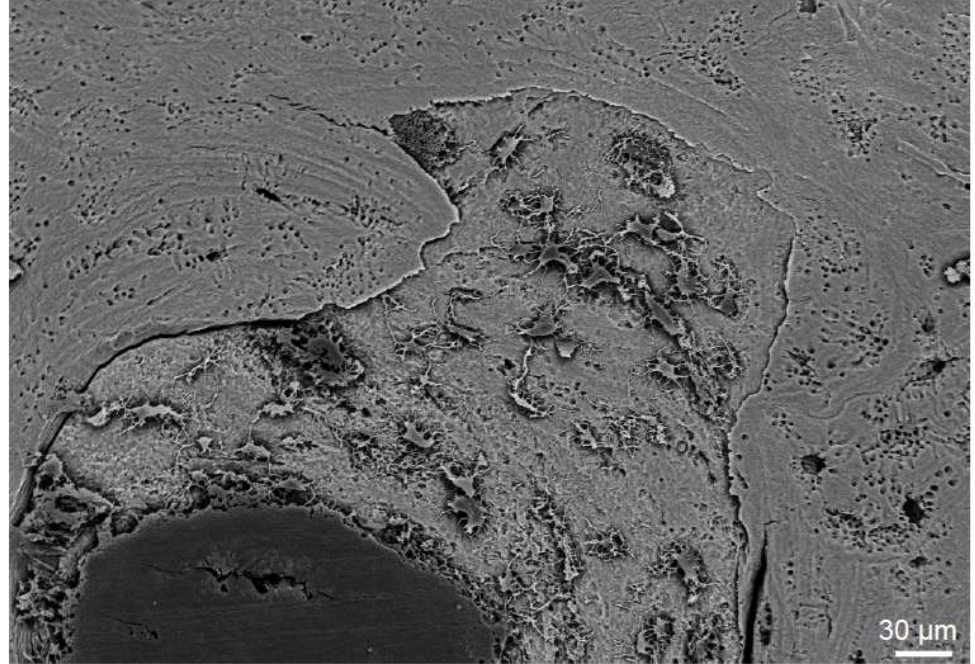
Figure 4. Scanning electron microscopy (SEM) image of an acid-etched human allograft bone specimen, demonstrating the interface of the dead allograft bone and the new bone growth with viable and connected osteocytes on the graft.